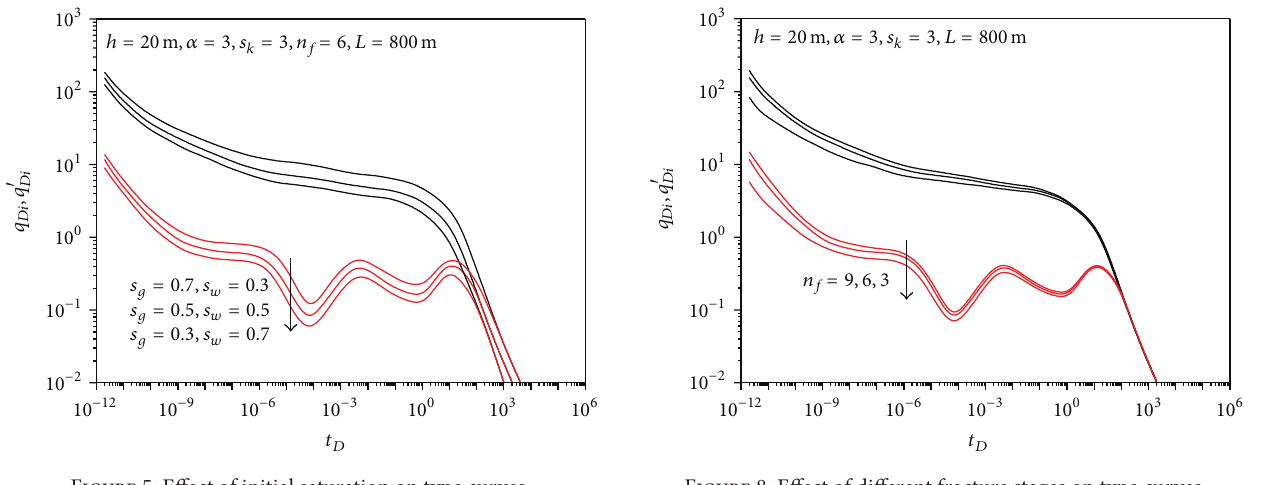
Figure 5: Effect of initial saturation on type curves.